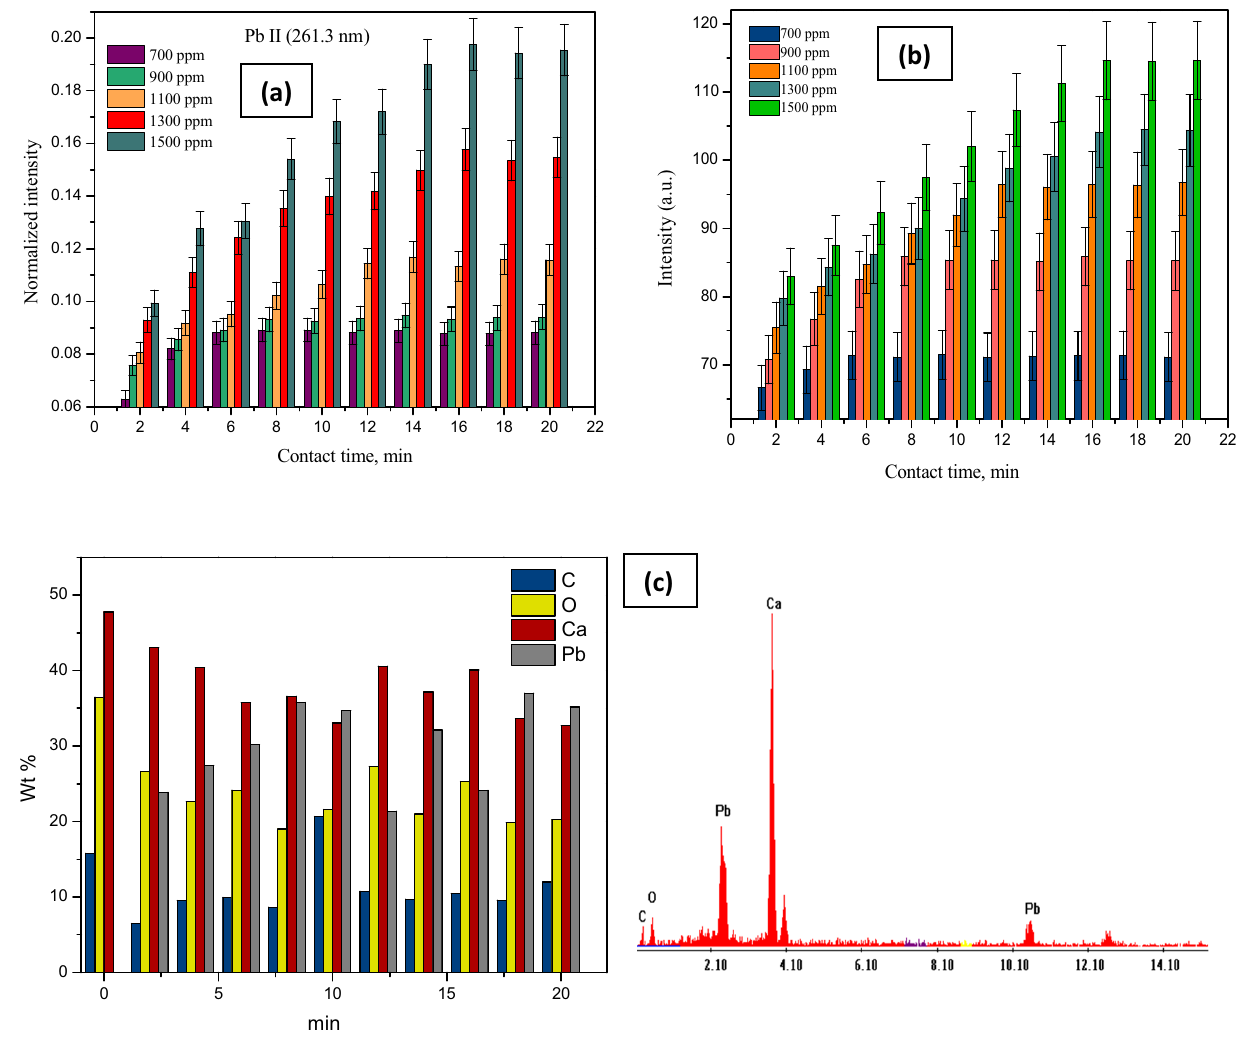
Fig. 5 Effect of contact time on Pb (II) adsorption on nano- CaCO